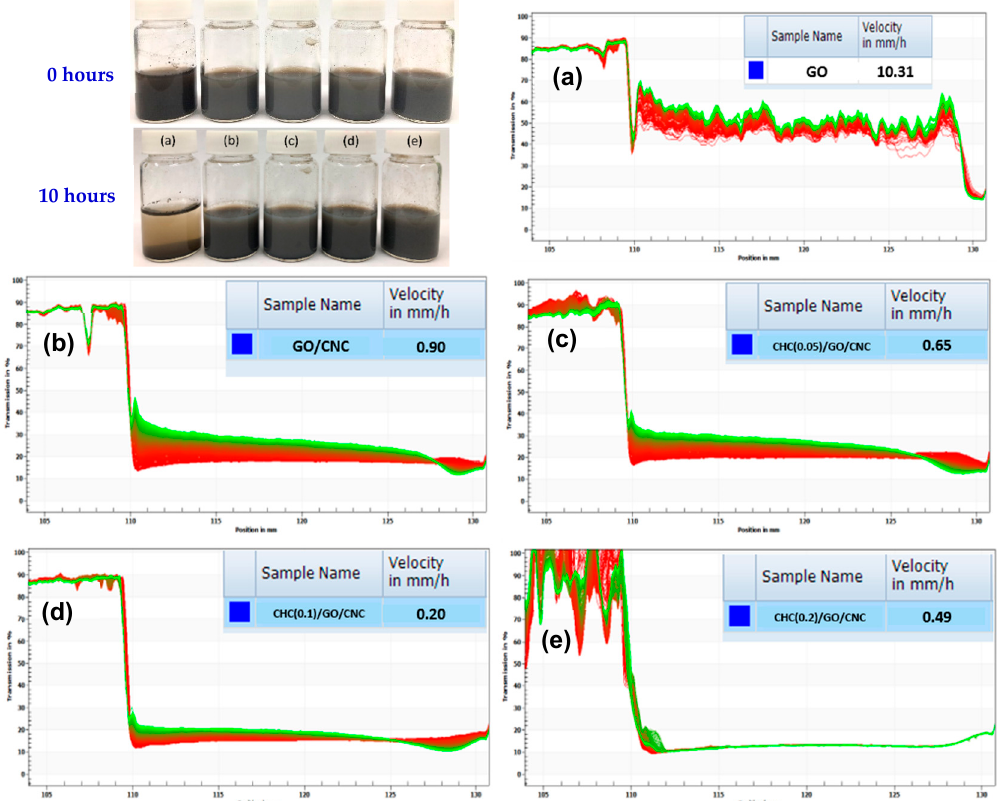
Figure 6. The sedimentation test at the initial state and after 10 hours incubation in the water solution; and the Lumisizer ® test (the sedimentation rate) of ( a ) GO; ( b ) GO/CNC, and the CHC/GO/CNC nanocomposite suspension with the different CHC concentrations of ( c ) 0.05 wt%; ( d ) 0.1 wt%; and ( e ) 0.2 wt%.